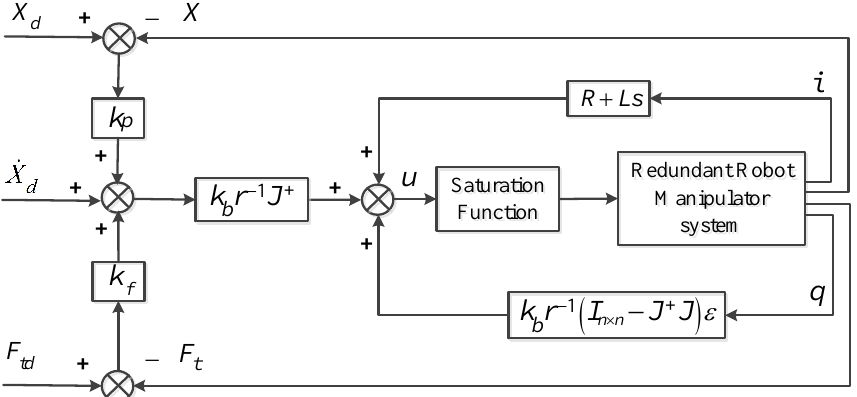
Figure 1. Voltage-based weighted hybrid force/position control strategy.